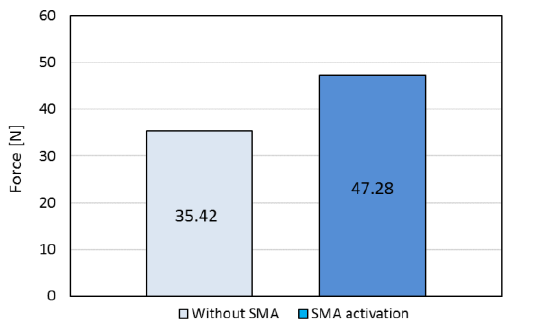
Fig. 18. Average force pulsation – side